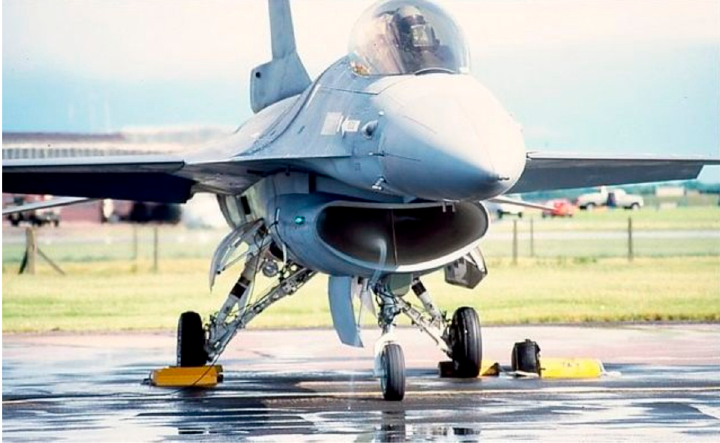
Figure 1. Water whirlpool being created as the result of air sucked in by the jet engine. Source: [4].